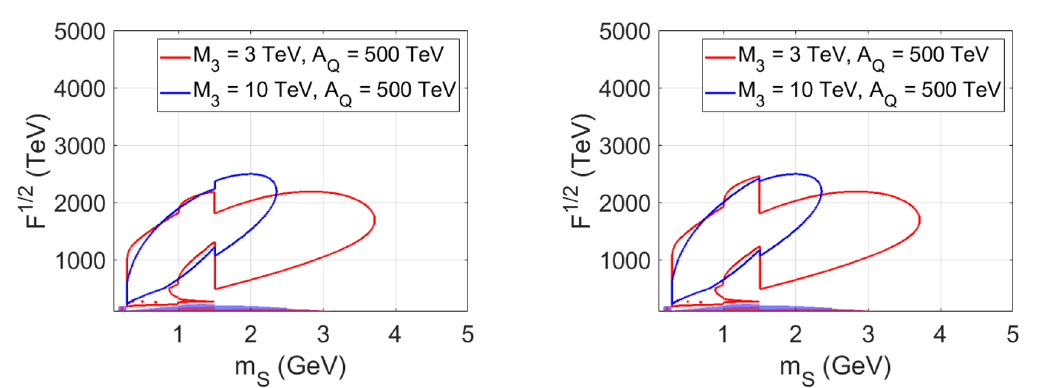
Figure 20 . The regions to be tested with FASER-II detector. Sgoldstinos are produced by B - mesons and decay into light mesons (pions and kaons) if m S < 1 . 5 GeV and into pair of gluons if m S > 1 . 5 GeV. Only charged mesons are accounted for the left plot. Both charged and neutral meson are treated as viable signatures for the right plot. M γγ = 100 GeV. Shaded areas correspond √ √ to restrictions from table 1. In the regions where F < A Q we set A Q = F